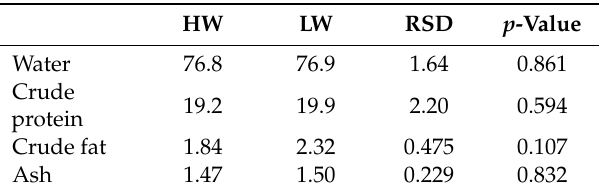
Table 4. Chemical composition (g / 100 g fresh matter; M. longissimus thoracis ) of meat in lambs born with high (HW) or low